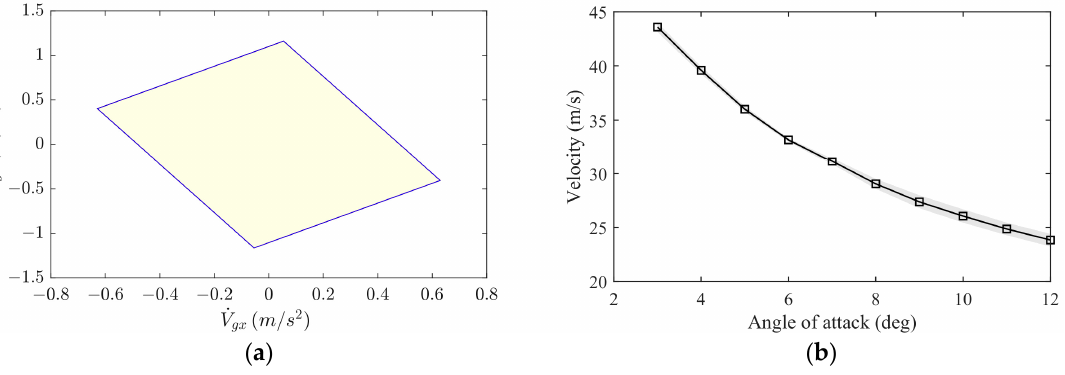
Figure 12. AAS area and equilibrium points curve: ( a ) AAS area (angle of attack = 6 deg, sink rate = − 1 m/s, and velocity = 35 m/s) and ( b ) equilibrium points curve.